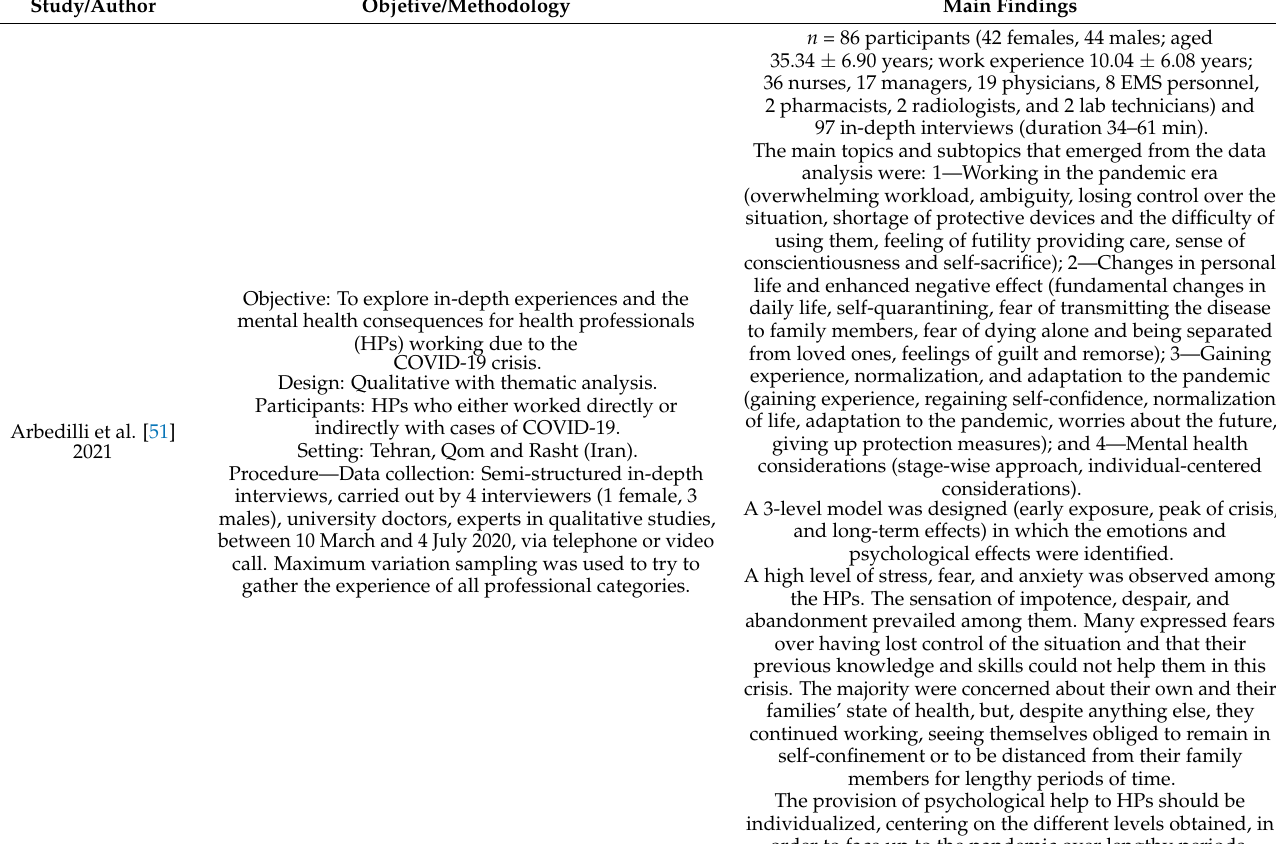
Table 2. Characteristics of the studies included in the living systematic